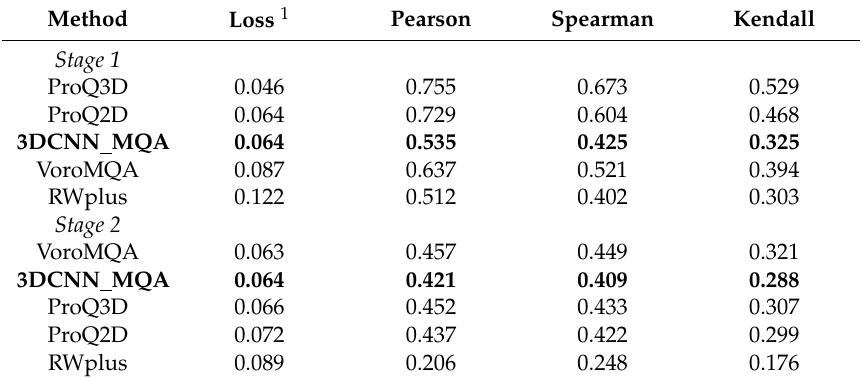
Table A5. Performances of 3DCNN MQA and other state-of-the-art MQA methods on CASP11 Stage 1 and Stage 2 [91].